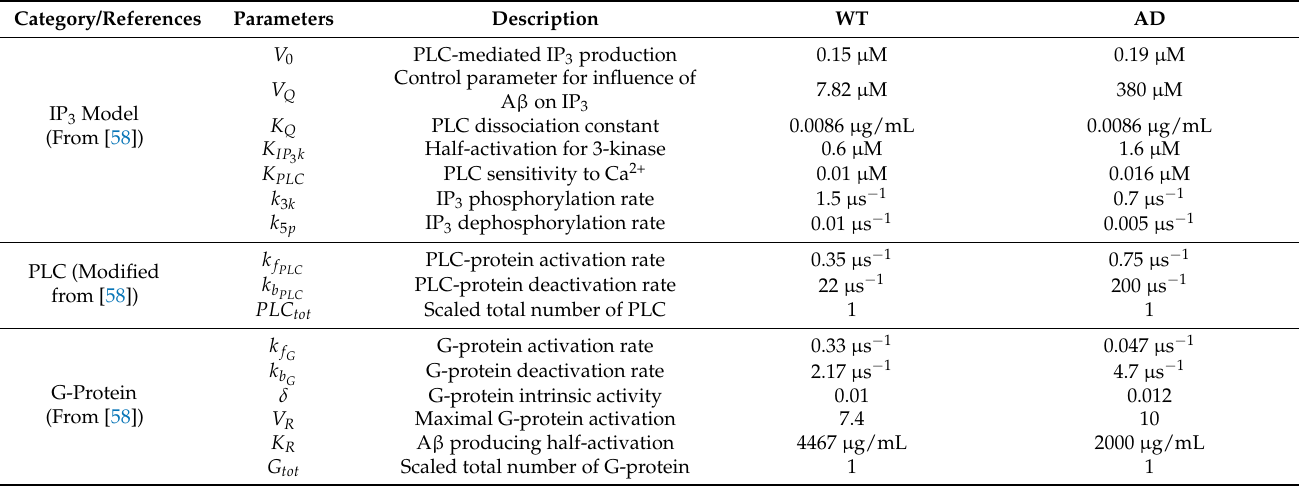
Table 6. Parameter values for the IP 3 dynamics and IP 3